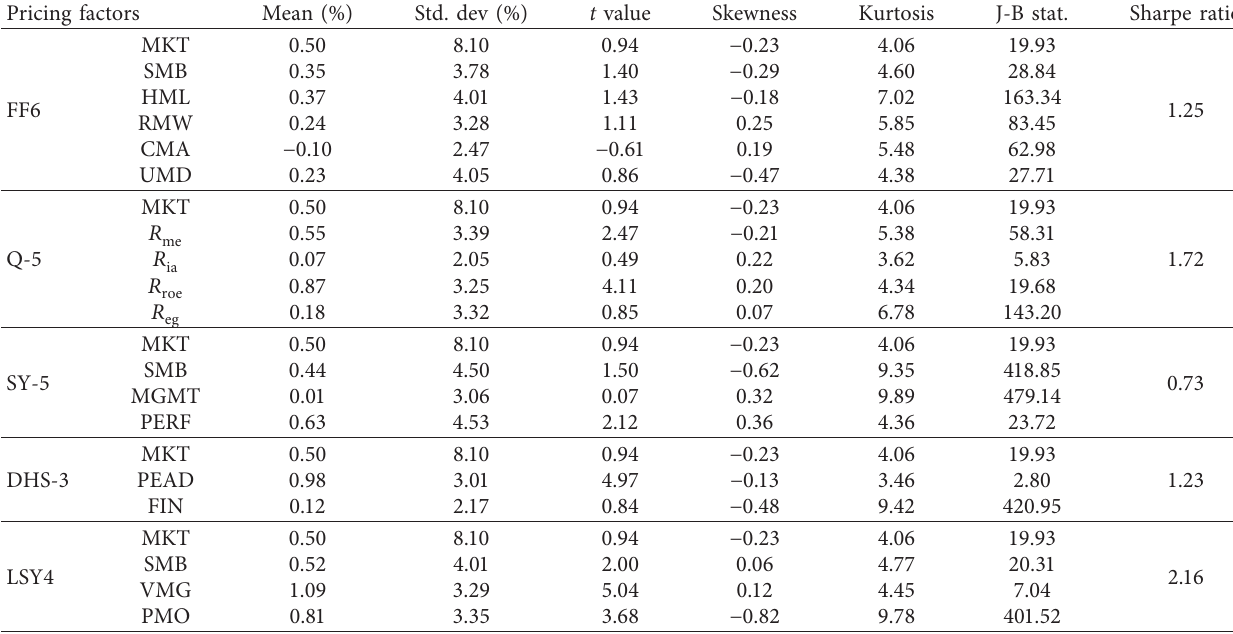
Table 2: Summary statistics of pricing factors. This table shows means, standard deviations, t -statistics, skewness, kurtosis, and Jarque–Bera statistic of each pricing factor and the maximum Sharpe ratio achievable from each factor model. The sample period is from July 2000 to December 2019. The first to last row correspond to the Fama–French 6-factor model [10], the Hou–Xue–Zhang q5-factor model [2], the Stambaugh–Yuan 4-factor model [21], the Daniel–Hirshleifer–Sun 3-factor model [22], and the Liu–Stambaugh–Yuan 4-factor model [15]. Pricing